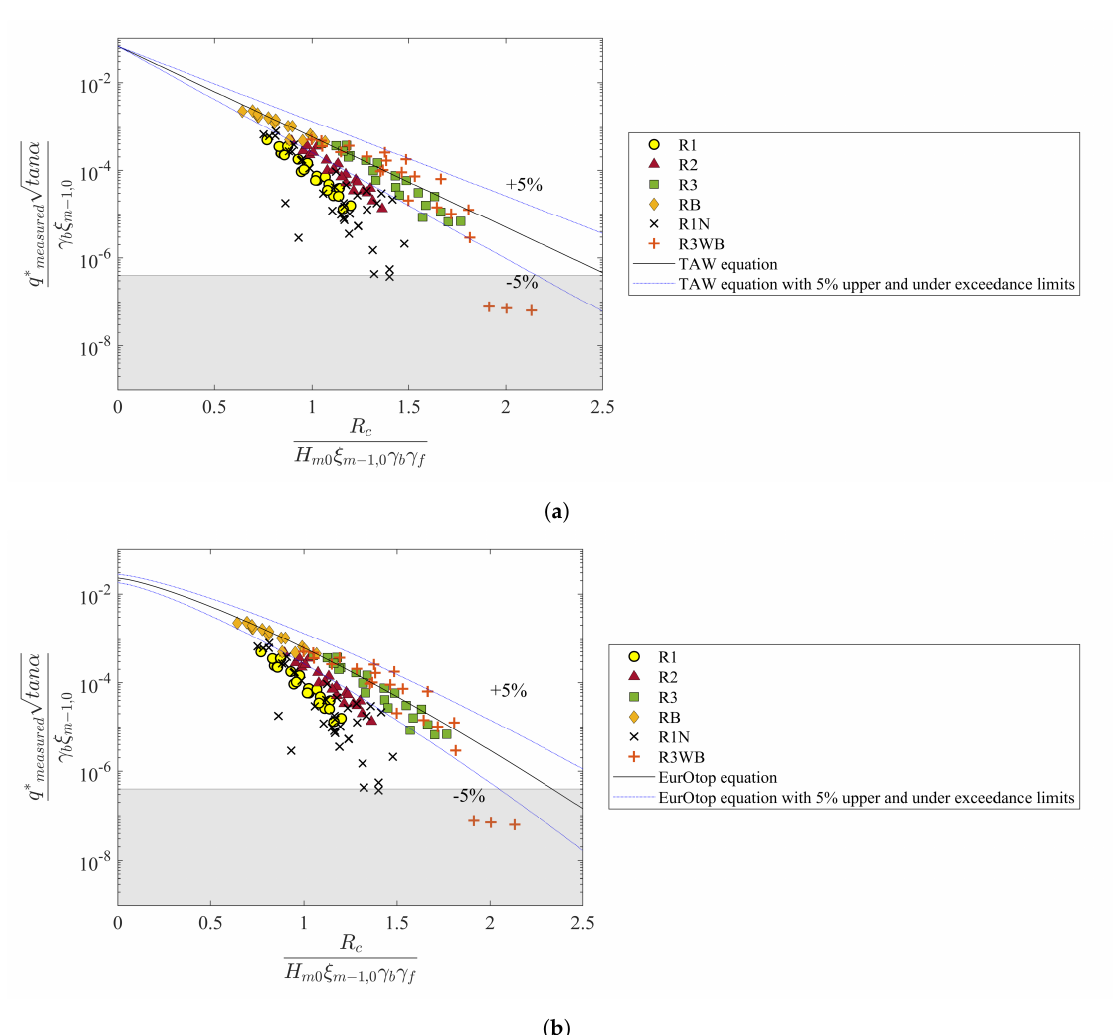
Figure 12. Comparisons between measured overtopping data and empirical equations from ( a ) [6] and ( b )